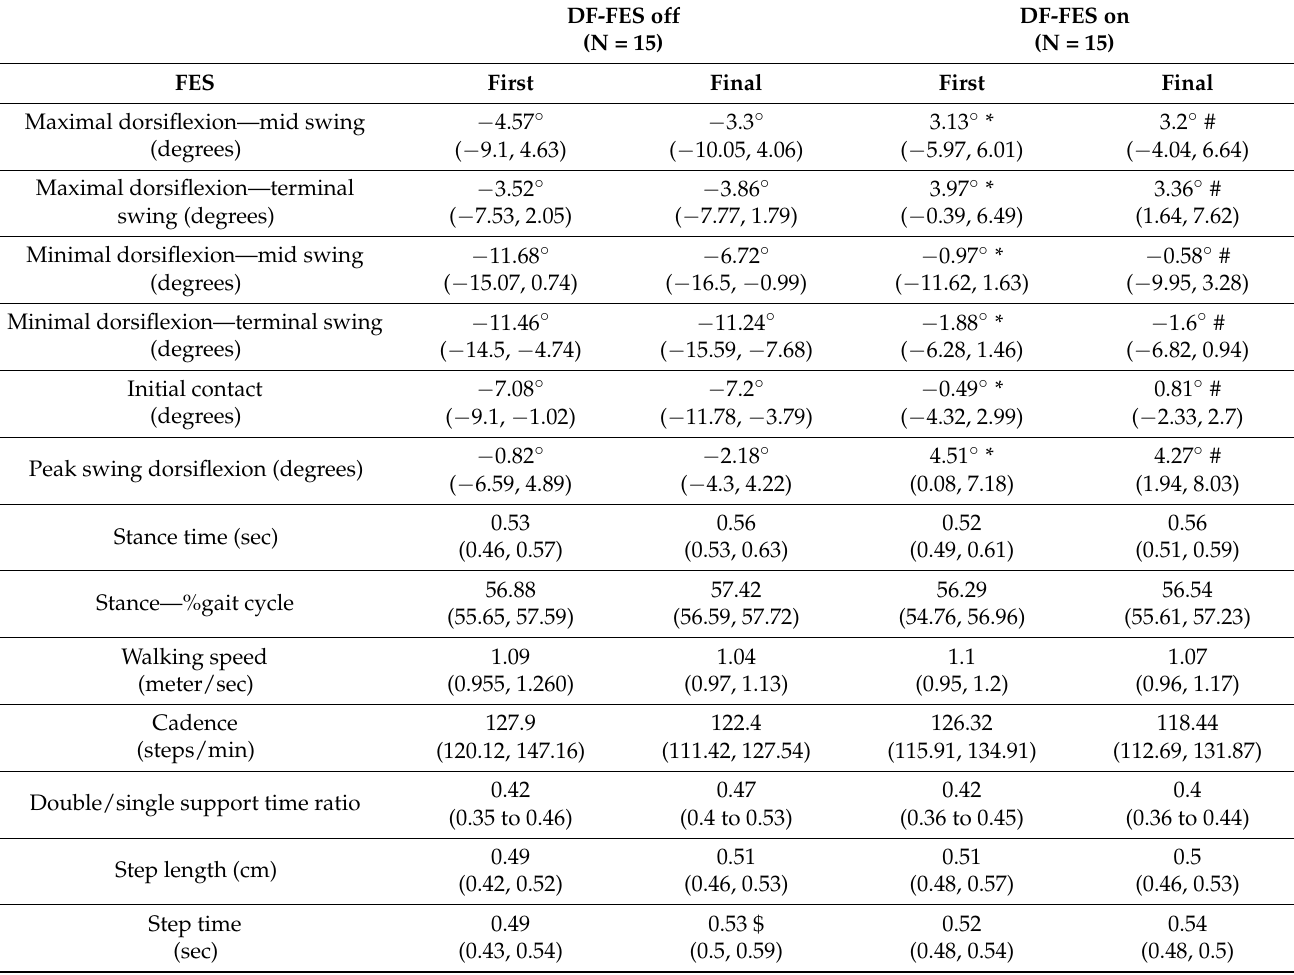
Table 3. Ankle kinematic and spatiotemporal parameters with DF-FES off and on at the first and final gait